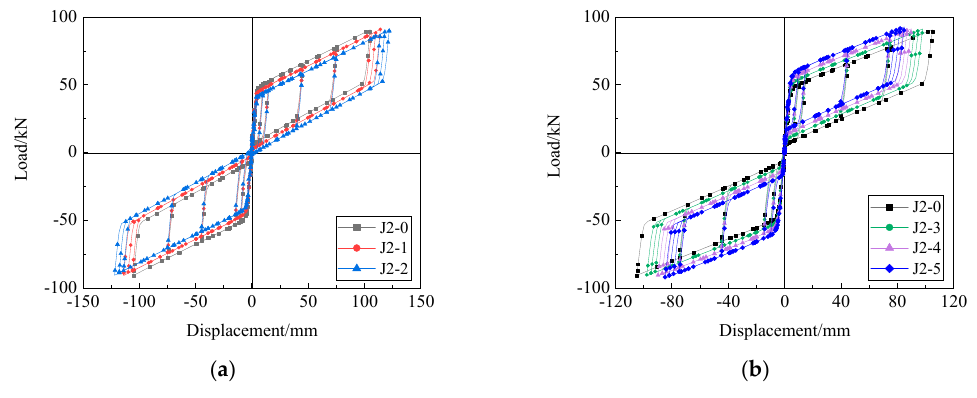
Figure 20. Load–displacement curves: ( a ) J2-0~J2-2; ( b ) J2-0, J2-3~J2-5. If the inflection points of the load–displacement curves (when the joint is opened) were defined as the yield of joints, with the decrease in the prestress of steel strands, the deformations of each joint from the opening to the maximum bearing capacity (yield of